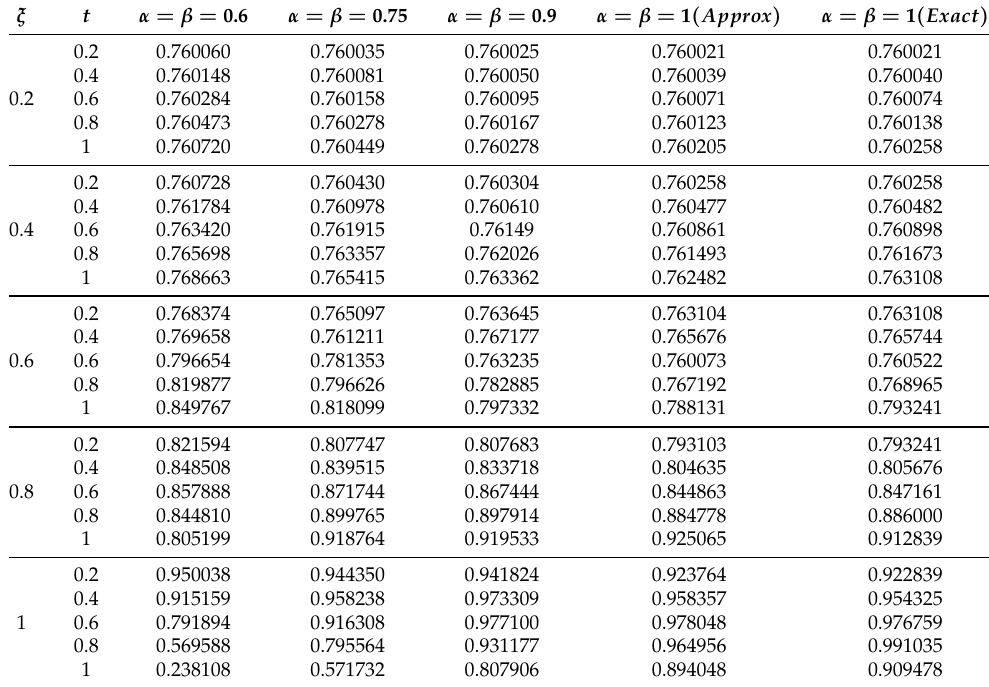
Table 1. The exact, NTDM CF and NTDM ABC solutions of v ( ξ , ζ , τ ) for Example 1 at different fractional-order of α and β with l = 4 for different ξ and τ when ζ = 1.